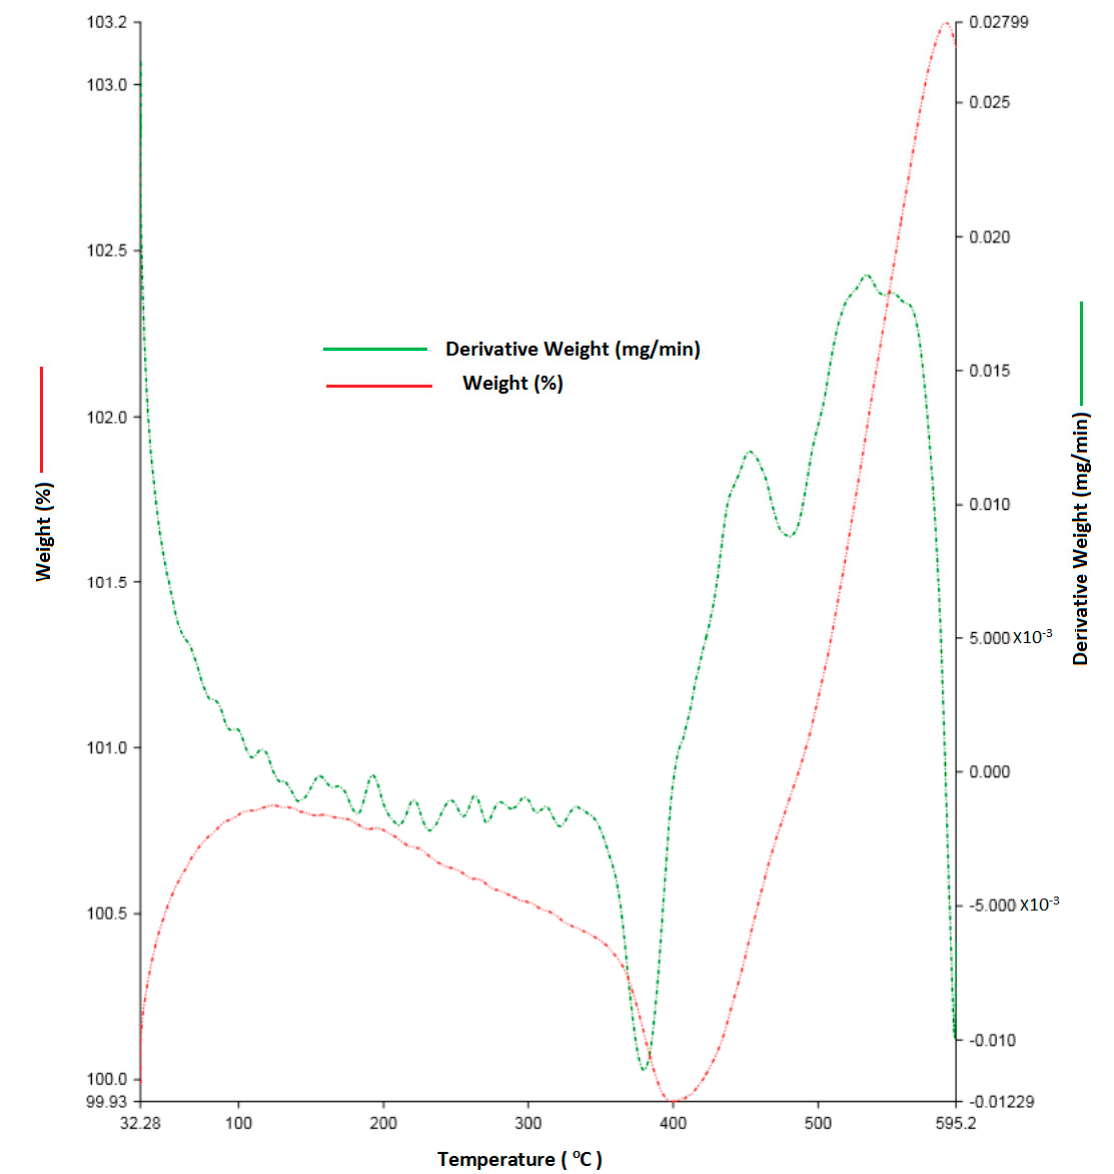
Figure 1. Thermogravimetric analysis of biodegradable Zn alloy.